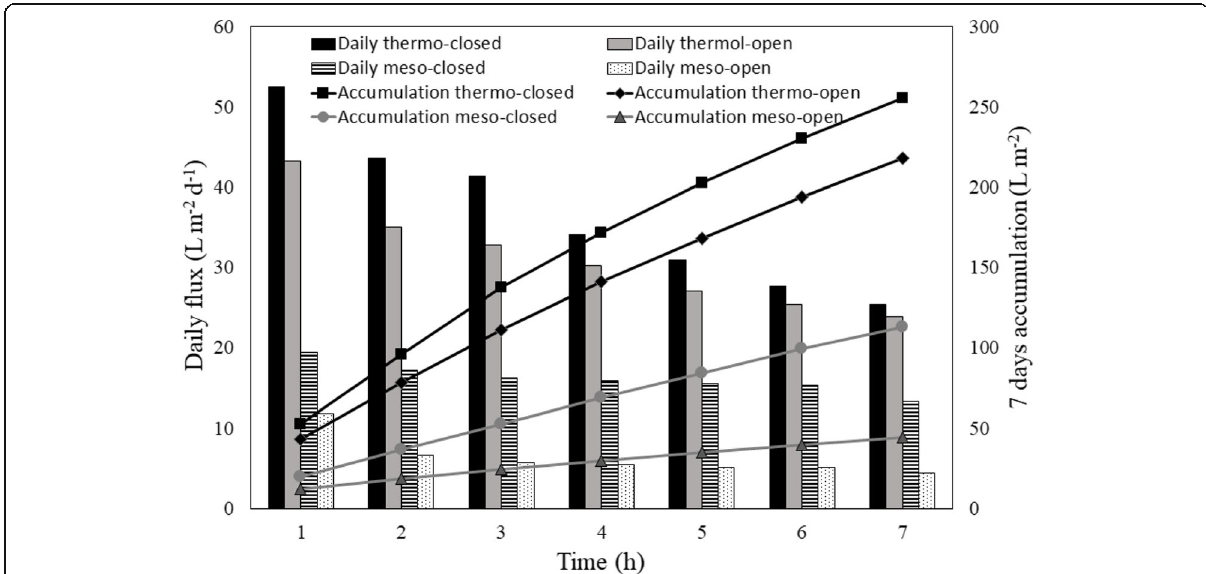
Fig. 5 Accumulation and daily water flux of the thermo-MFC and meso-MFC using open- or closed-circuit modes. The average water fluxes are 36.5 and 31.1 L m − 2 d − 1 ) for the closed- and open-circuit thermo-MFCs, which are higher than 16.2 and 6.3 L m − 2 d − 1 for the closed- and open- circuit meso-MFCs,